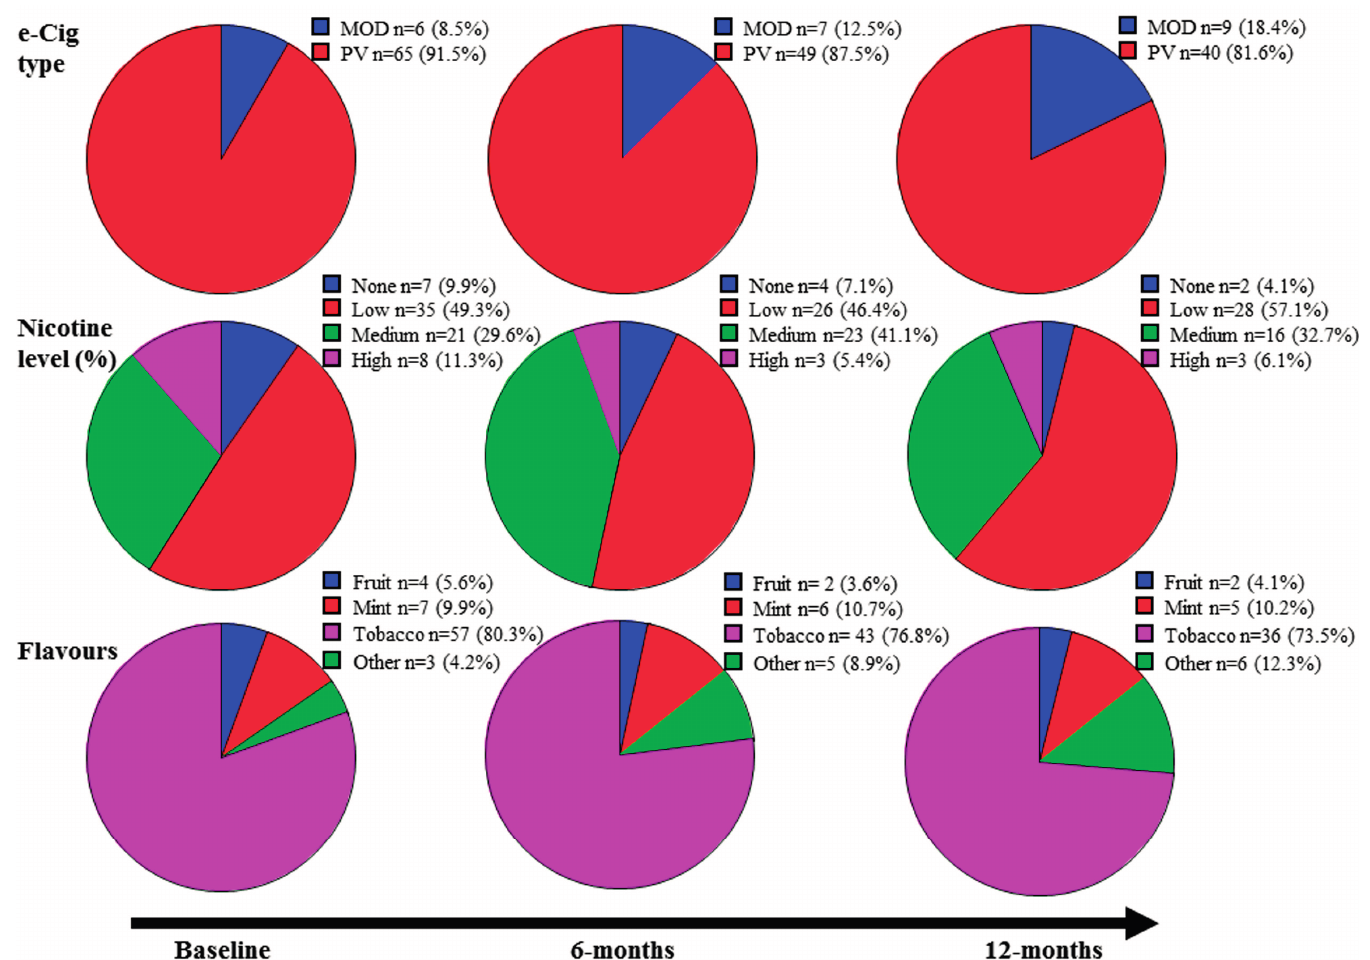
Figure 2. Details of e-Cigs type, e-liquid nicotine strengths (%) and flavours purchased at baseline and at 6 and 12 month follow-up visits. PV: personal vaporizers. MODs: more advanced devices. Low nicotine (4–9 mg/mL), medium nicotine (12–18 mg/mL), high nicotine (19–24